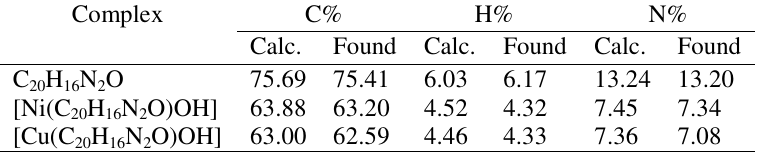
Table 2. Elemental analysis data of the ligand and its complexes.